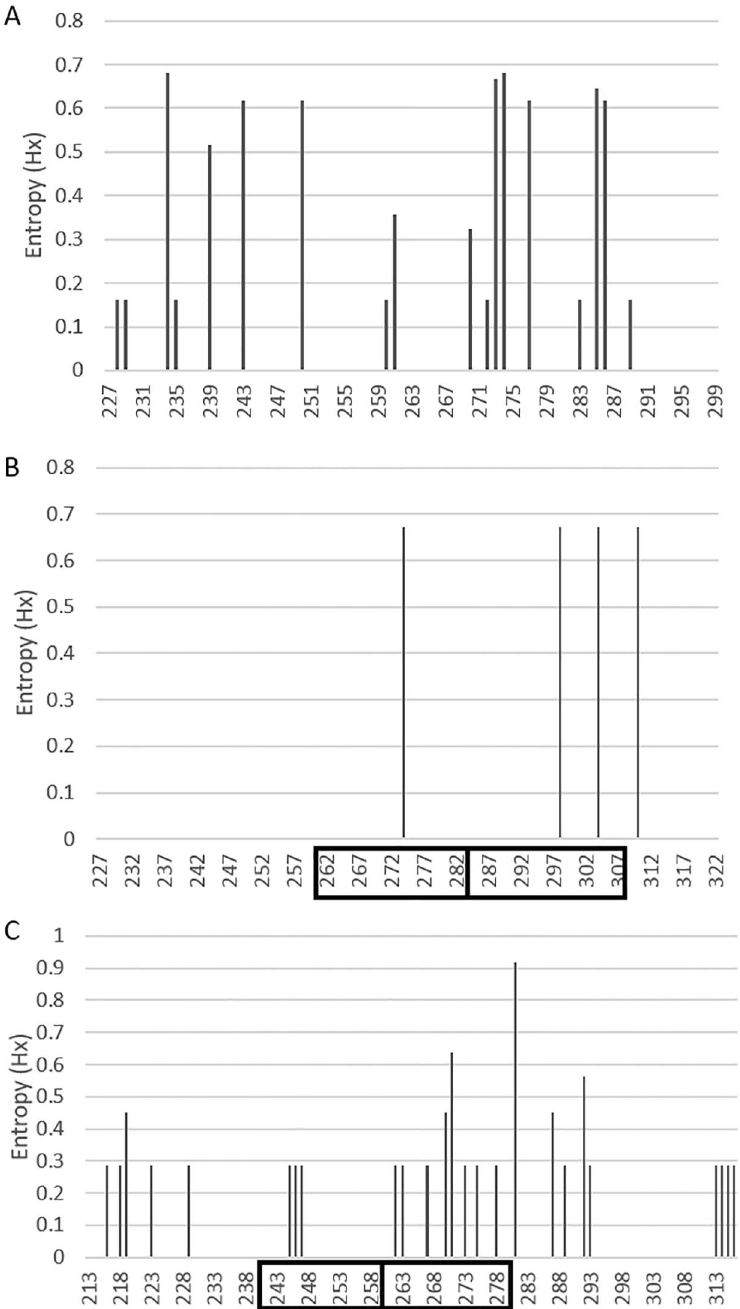
Fig 5. Shannon entropy plots of deduced amino acid sequences of the second hypervariable region of the G protein. The data set includes (A) RSV-A: NA1 genotype, n = 26 (B) ON1 genotype, n = 05 and (C) RSV-B: BA genotype, n = 11 of Saudi strains with their respectiveprototypestrains. The entropy plots show the amino acid variabilityin the second hypervariableregionof the G protein genedeterminedby BioEdit software. The thresholdvalue was set at 0.2. Amino acid sites with entropy values < 0.2 are considered conservedand values > 0.2 are considered variable.